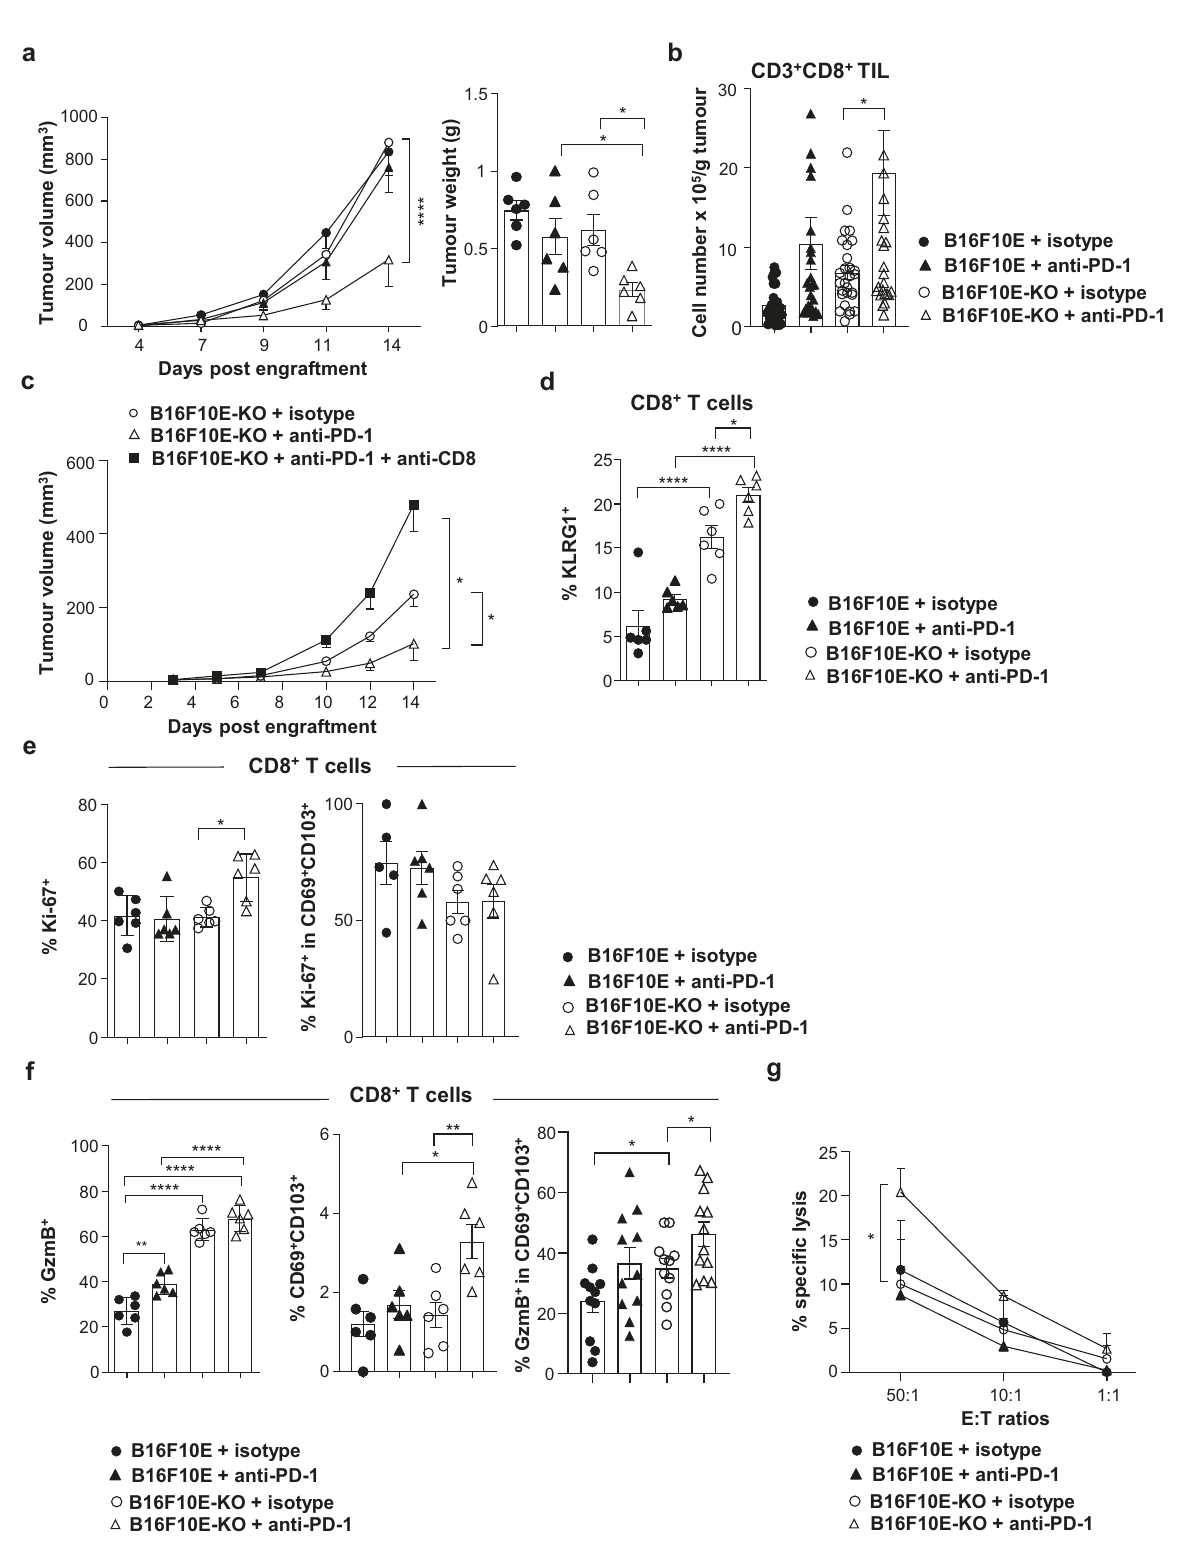
and molecular data were collected (Supplementary Tables 1 and 2). Radi- ological assessments were performed every 8 weeks per RECIST v1.1